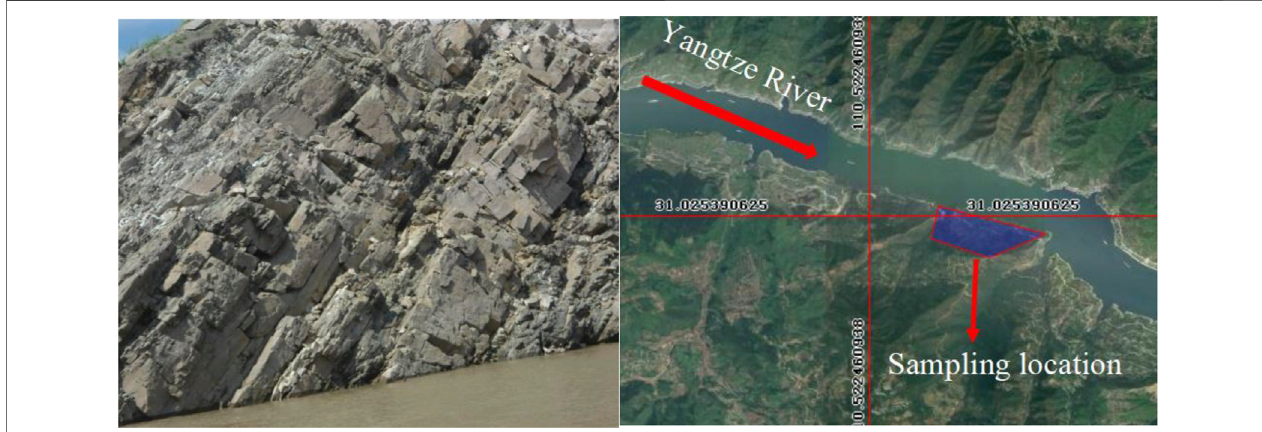
FIGURE 1 | Schematic diagram of the rock mass in the fi